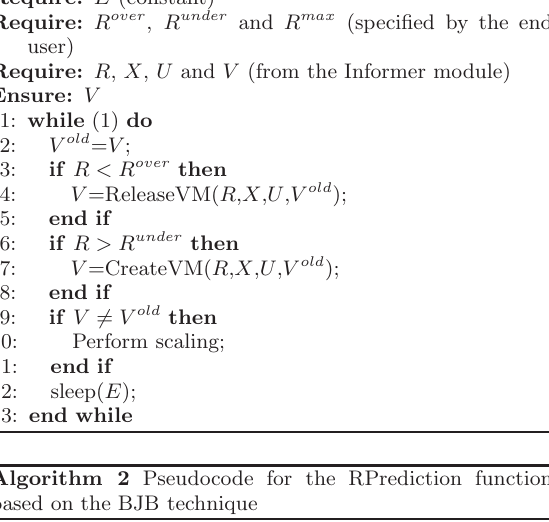
Algorithm 2 Pseudocode for the RPrediction function based on the BJB